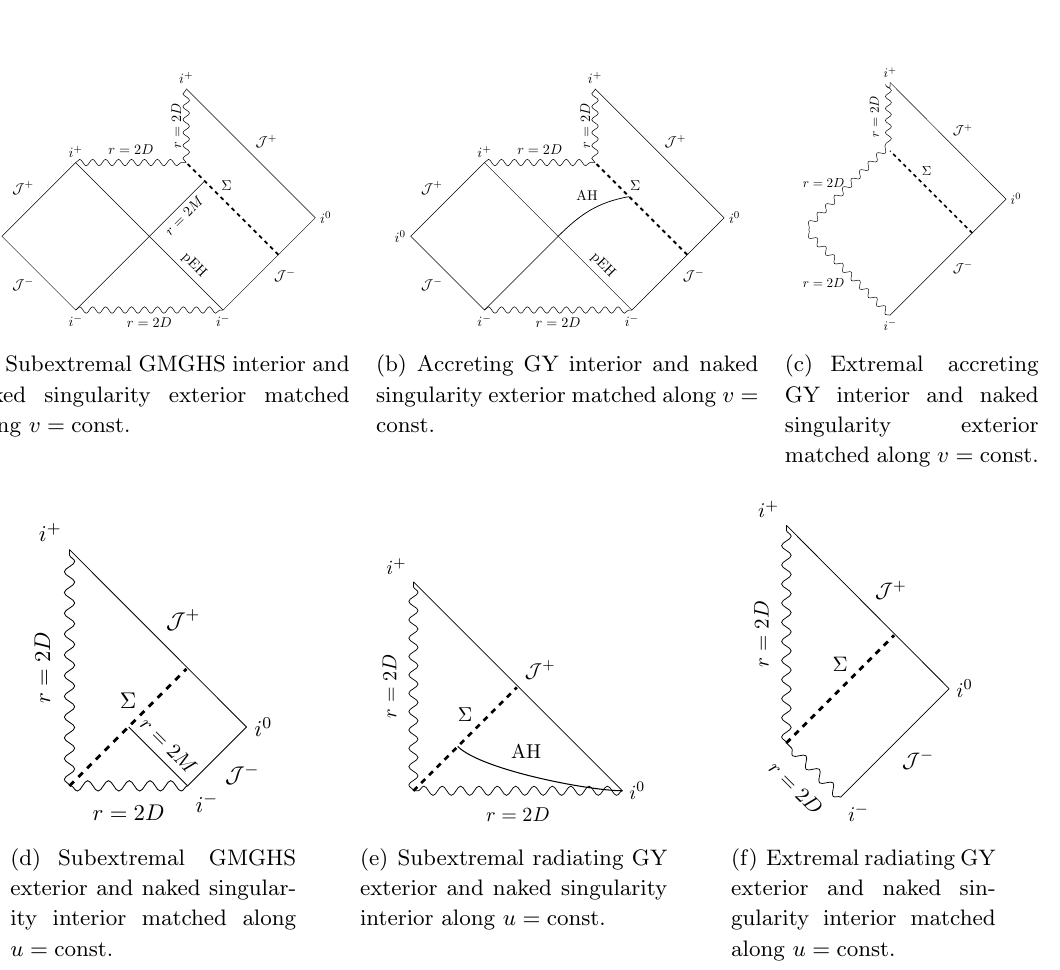
Figure 6 . Carter-Penrose diagrams for global solutions obtained by matching along a null hy- persurface. All of these matchings yield a spacetime with the same global asymptotic structure of Minkowski, except for (cid:12)gure